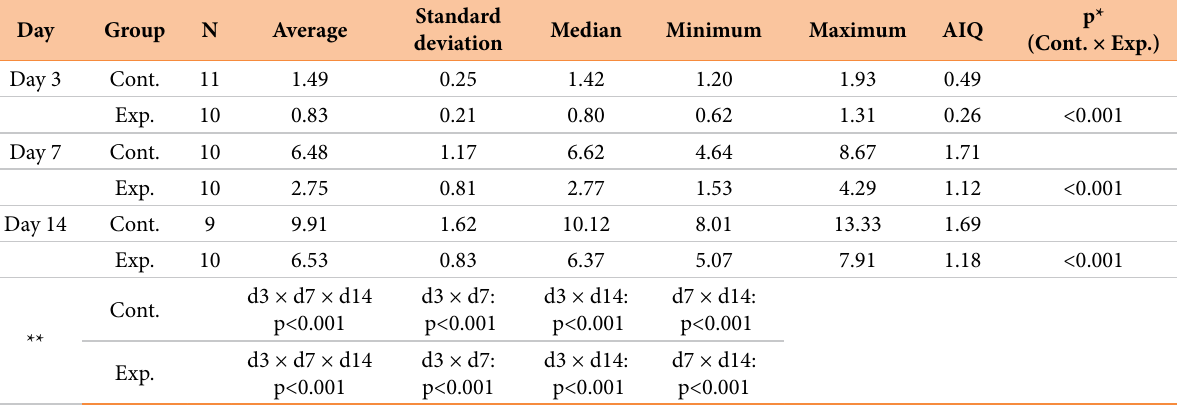
Table 7 - Average area occupied by collagen I, using picrosirius-red F3BA.